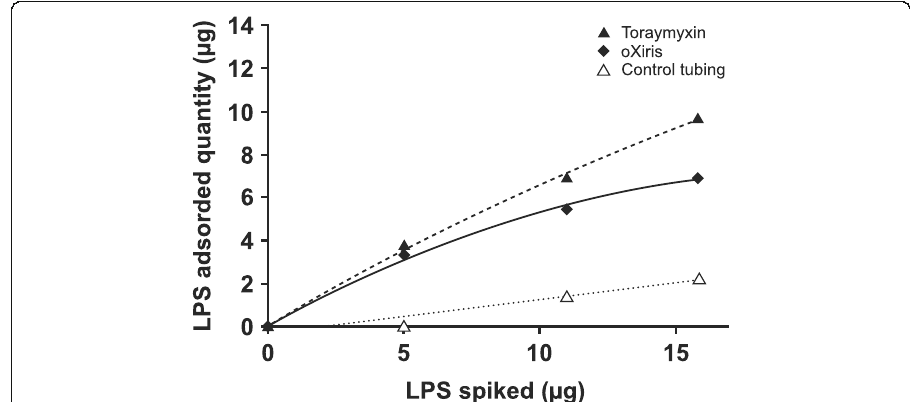
Fig. 3 LPS adsorption isotherm obtained with oXiris and Toraymyxin blood purification devices. Abbreviation : LPS